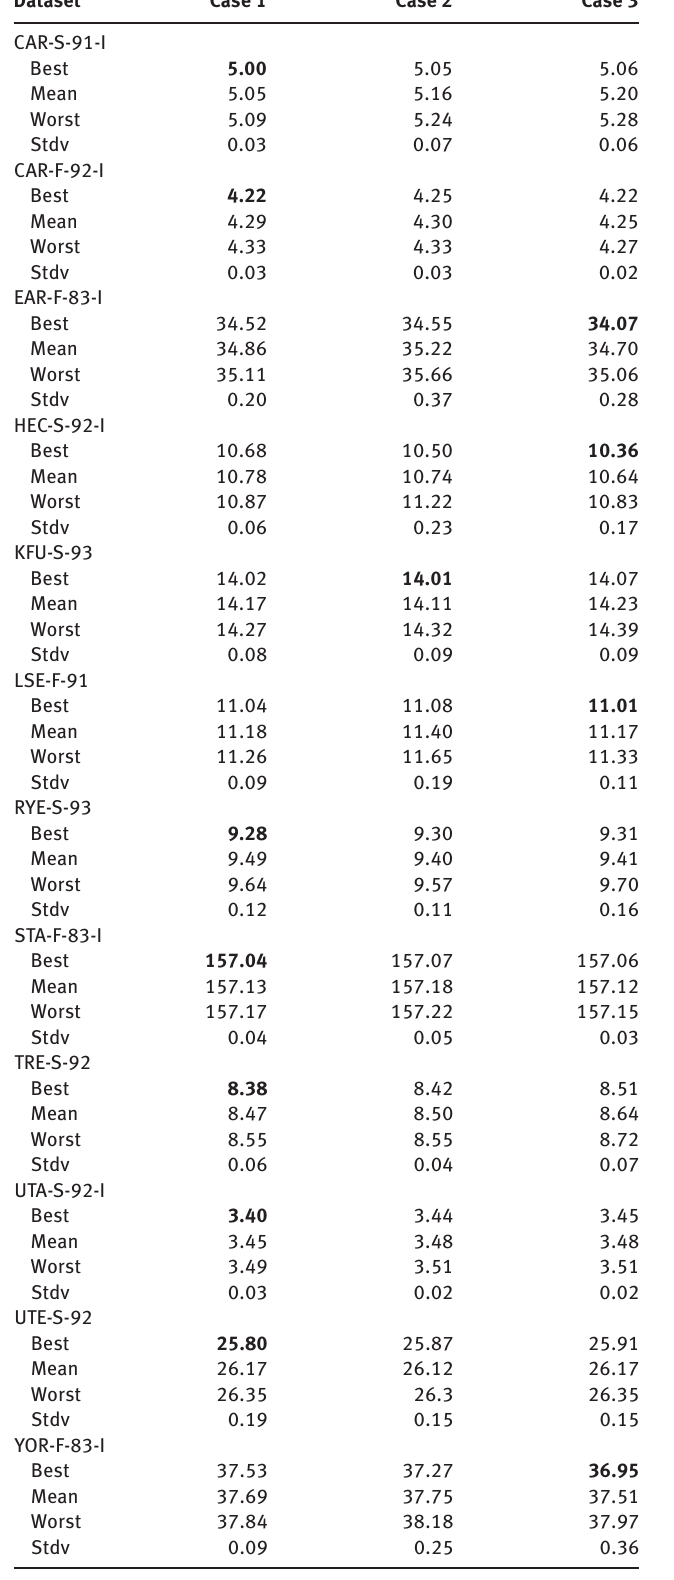
Table 5. Experimental Results of HABC on